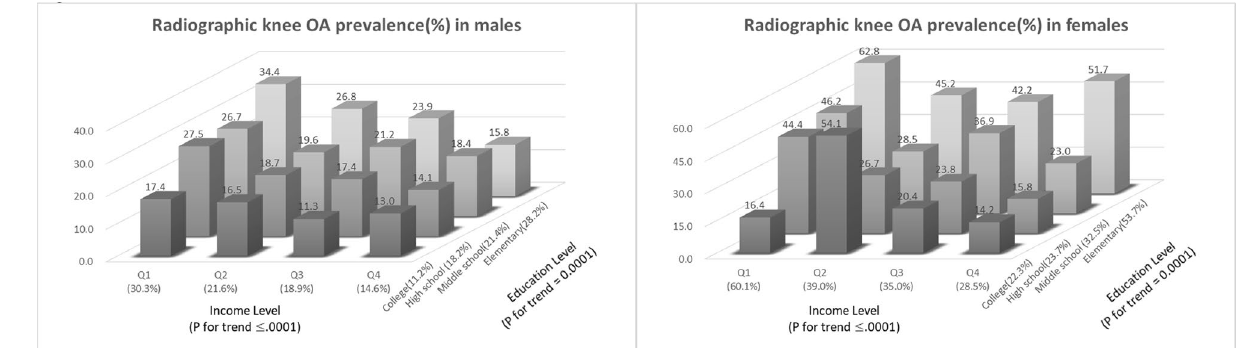
Figure 1. The prevalence of knee osteoarthritis (OA) according to income level and education participants. Although those with the lowest income and lowest education showed the highest prevalence of knee OA (62.8%), those with the highest income level with low education status and those with highest educa- tion status with the second to lowest income level also had a high prevalence of radiographic knee OA (51.7% and 54.1%, respectively). When we ran the model with only participants with radiographic knee OA, knee symptoms were more preva- lent in those with lower educational status in men and lower income level in women (Fig. 2). Severity of radiographic knee OA according to income, education, and occupation. Figure 3 shows the radiographic severity of knee OA according to the levels of the three determinants of SES. Males or females who earned less income significantly were more likely to have severe radiographic knee OA, and this pattern was more evident in females. Of females in the lowest income quantile (Q1), 45.3% had moderate-to- severe knee OA, and this was evident according to education level and occupation. The more educated partici- pants had milder radiographic knee OA compared to the less educated who had more severe radiographic knee OA. Of females who were educated through elementary school, almost 40% had moderate-to-severe knee OA. Regarding occupation, unemployed participants or those with non-managerial jobs had more severe knee OA. In women, 13% without a job had severe knee OA, while 3% with managerial jobs had severe knee OA. In men, 3.7% without a job had severe knee OA, while 0.8% with managerial jobs had severe knee OA.